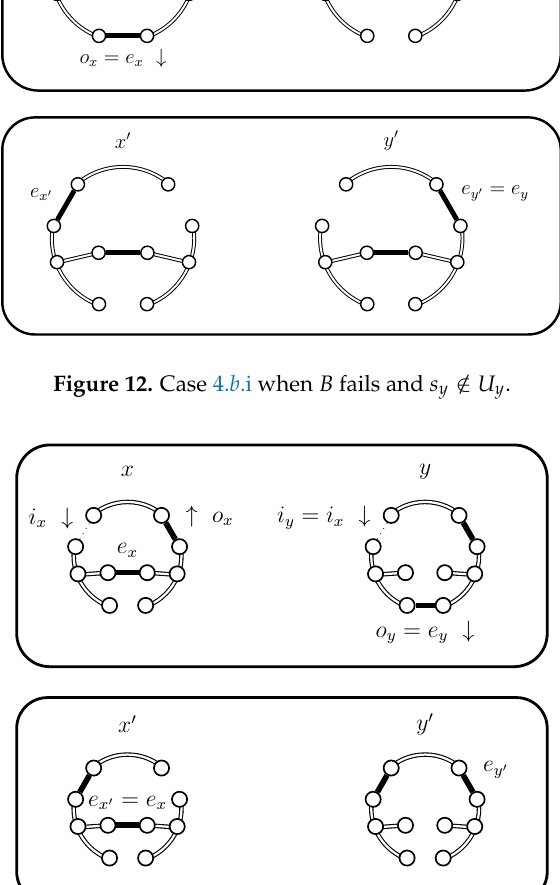
Figure 13. Case 4. b Figure 13: Case 4. b .ii.